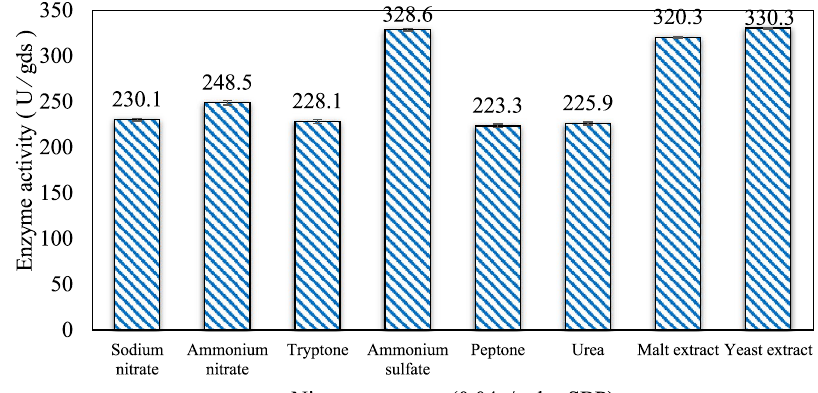
Fig. 1. Effect of different carbon sources on xylanase